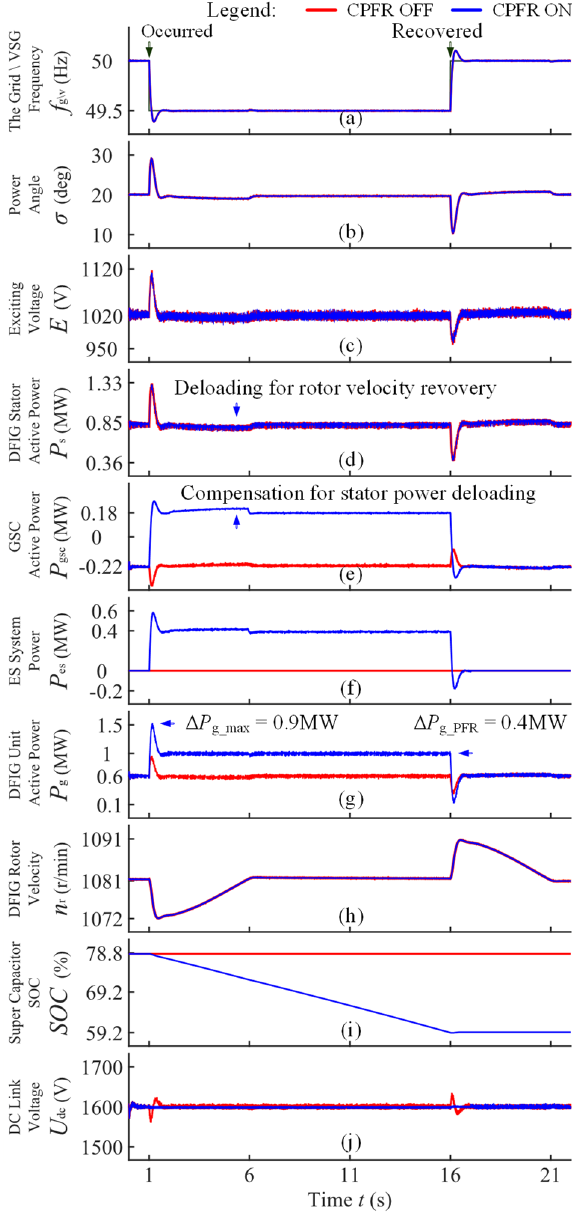
Figure 11. Frequency regulation operation waveforms of a DFIG-VSG at a low wind speed: ( a – c ) The frequency, power angle and exciting voltage of the DFIG-VSG; ( d – g ) The stator power, GSC power, ESS power and generator unit power; ( h ) The rotor velocity; ( i ) SOC of the super capacitor; ( j ) DC link voltage.